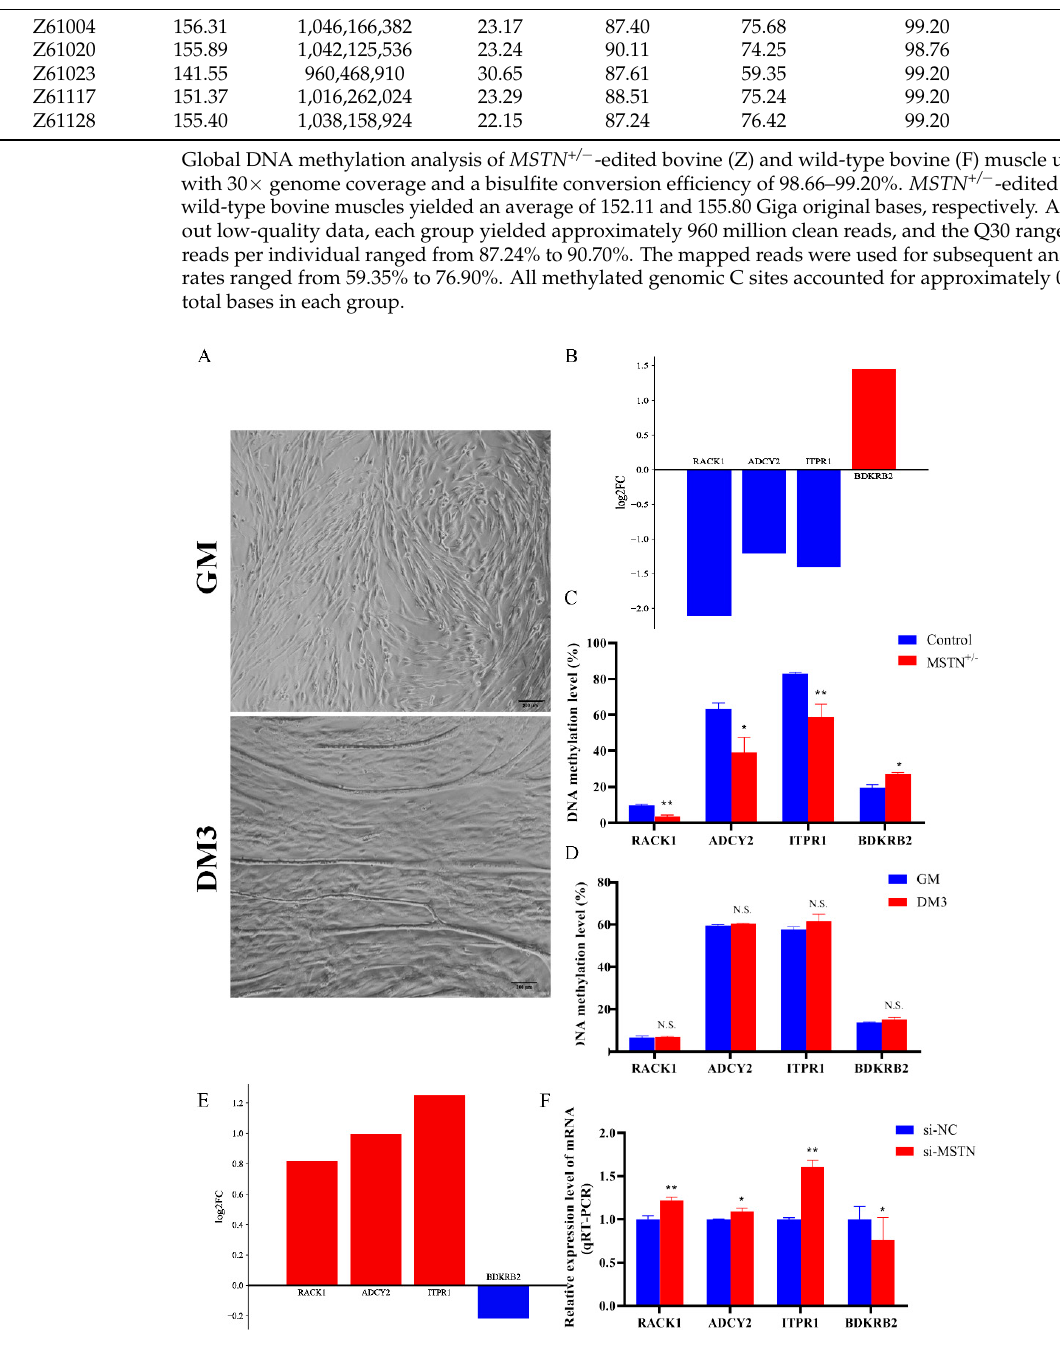
Figure 2. Accuracy verification of WGBS data. ( A ) Cell maps of GM and DM3 (100 × ). ( B ) Upregulation or downregulation of RACK1, ADCY2, ITPR1, and BDKRB2 in WGBS-seq data. ( C ) Histogram of DNA methylation levels (pyrosequencing) of muscle samples. ( D ) Histogram of DNA methyla- tion levels (pyrosequencing) of cell samples. ( E ) Upregulation or downregulation of RACK1, ADCY2, ITPR1, and BDKRB2 in RNA-seq data. ( F ) RT-PCR detection of RACK1, ADCY2, ITPR1, and BDKRB2 transcript levels. Differences between groups were statistically analyzed using Stu- dent’s t-test. p < 0.05 was considered statistically significant (* p < 0.05 and ** p < 0.01). And N.S., not significant ( p > 0.05). 3.2. Global DNA Demethylation Patterns Resulting from Myostatin Deletion The WGBS-seq results showed that the rank of DNA methylation of MSTN-edited (ZJY) DMRs was lower than that of the wild type (FZ) (Figure 3A). The results of the de- tection of 5-hydroxymethylcytosine (5hmC) hydroxylase TET activity showed that the up- regulation of 5hmC hydroxylase TET activity in cells was highly significant ( p < 0.01) (Fig- ure 3B). This indicates that myostatin gene deletion reduced the global DNA methylation levels of cells and dominated DNA demethylation modifications.